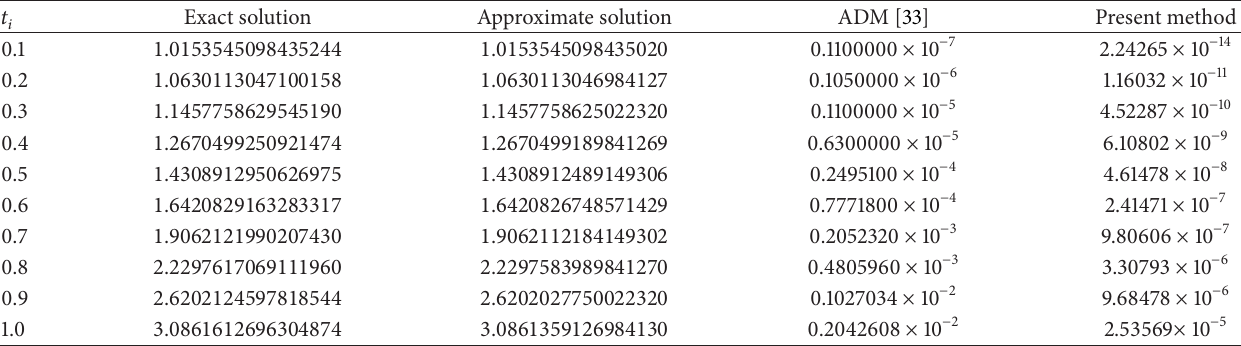
Table 1: Numerical comparison of the exact error function Ext 8 (𝑡) for 𝑥 1 (𝑡) to Example 1 in [0,1] .